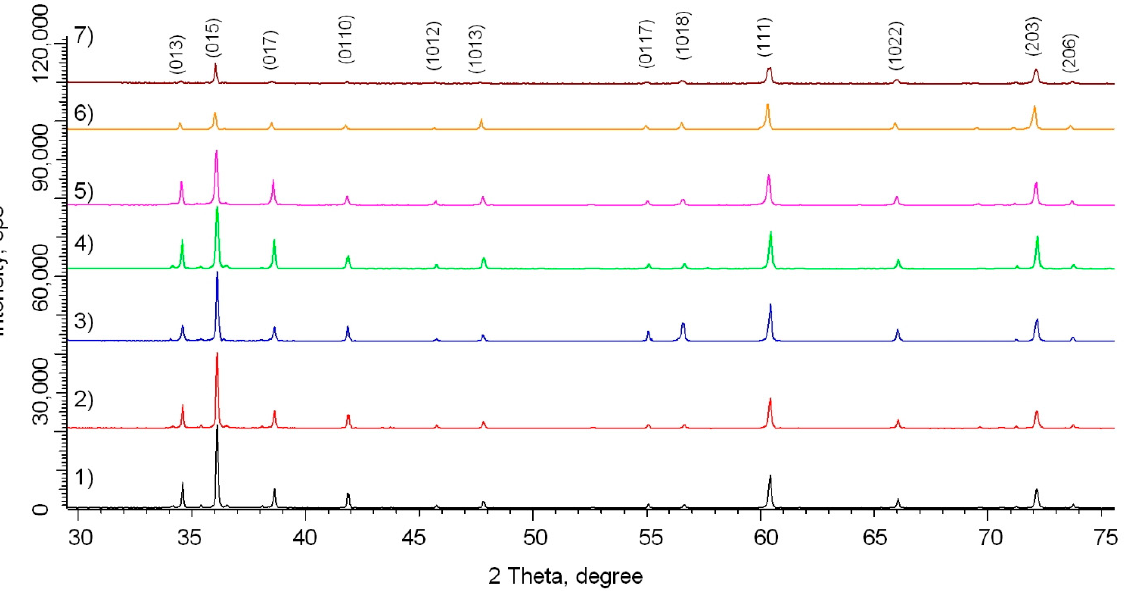
Figure 2. X-ray diffraction patterns of SiC ceramics depending on the fluence of irradiation with Не 2+ ions: (1) initial sample; (2) 10 15 ion/cm 2 ; (3) 10 16 ion/cm 2 ; (4) 5 × 10 16 ion/cm 2 ; (5) 10 17 ion/cm 2 ; (6) 3 × 10 17 ion/cm 2 ; and (7) 5 × 10 17 ion/cm 2